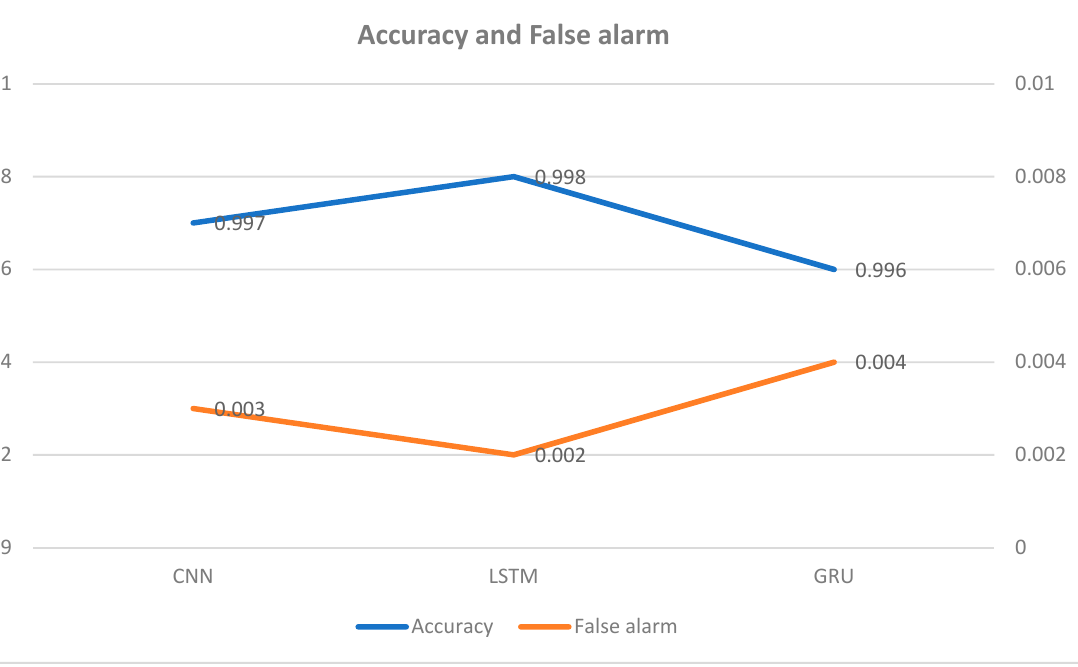
Figure 2. Experiment results for accuracy and false alarm.